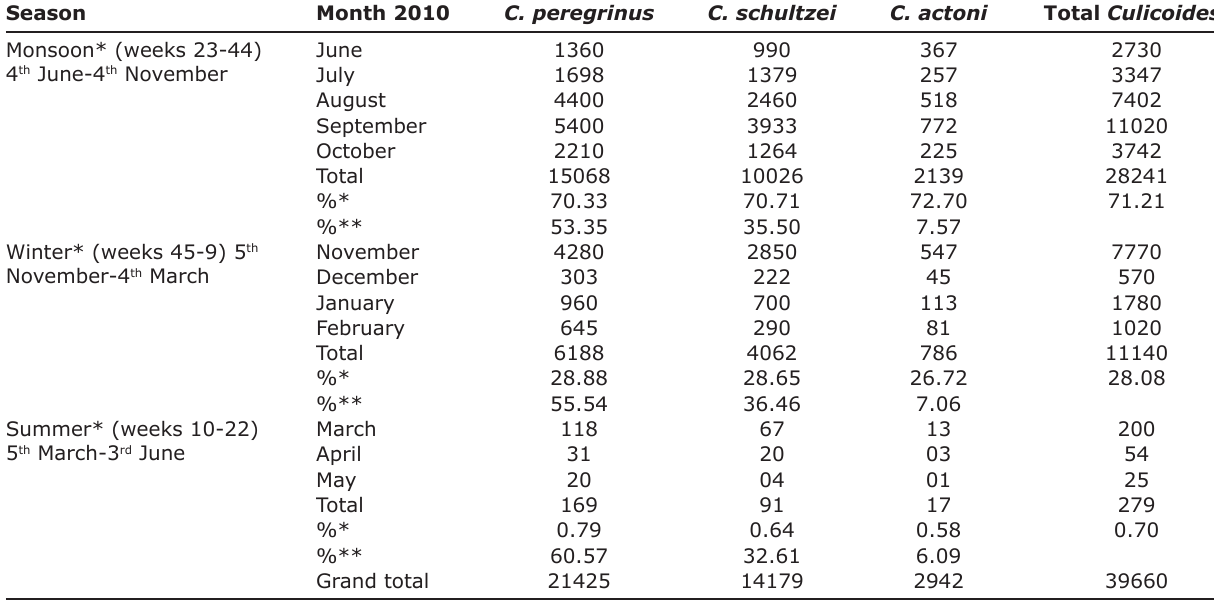
Table-3: Culicoides collected during the year 2010 and its relationship with average weather parameters at Parbhani (Marathwada) region of Maharashtra state @ .